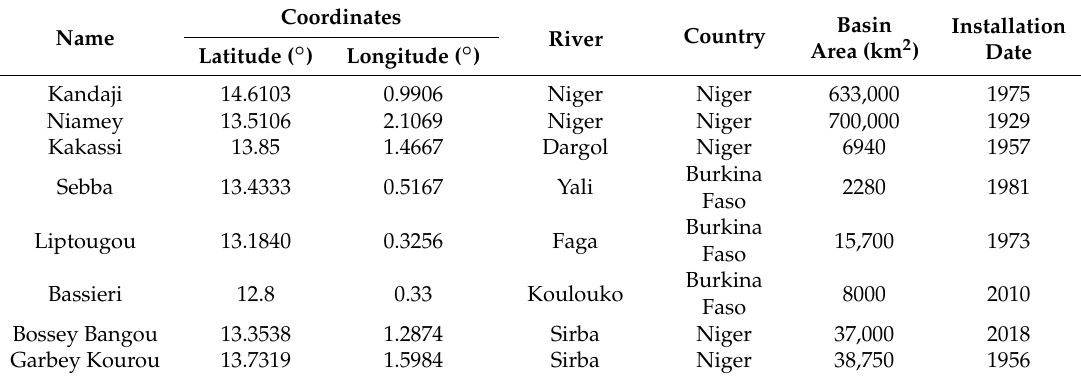
Table 2. Gauging stations in the analyzed